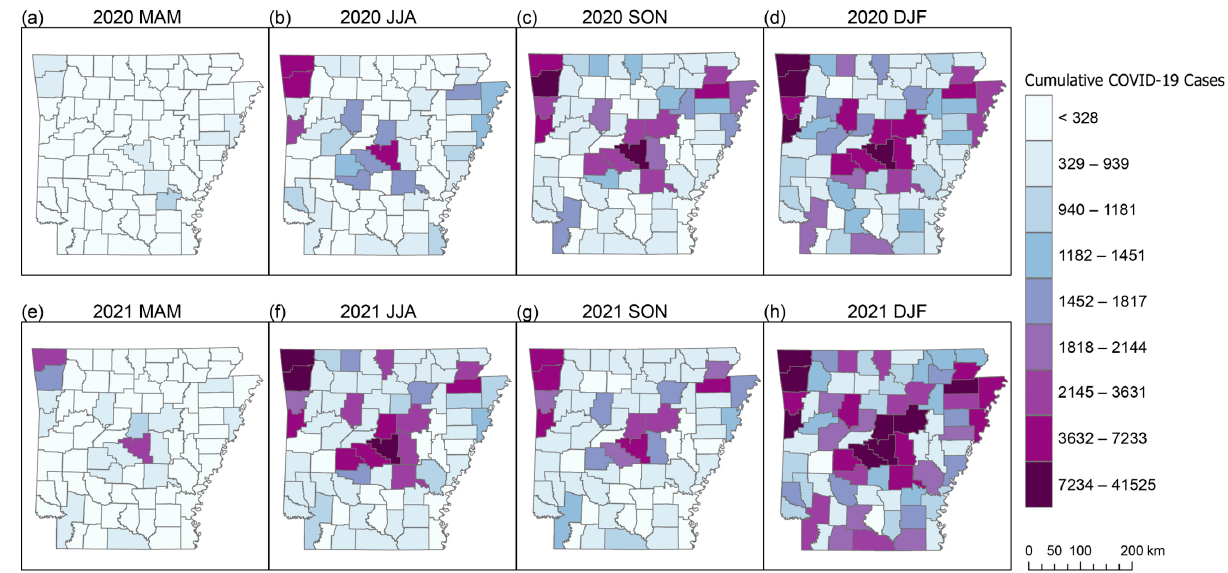
Figure 2. The cumulative COVID-19 cases for each season from 2020 to 2021. (MAM: